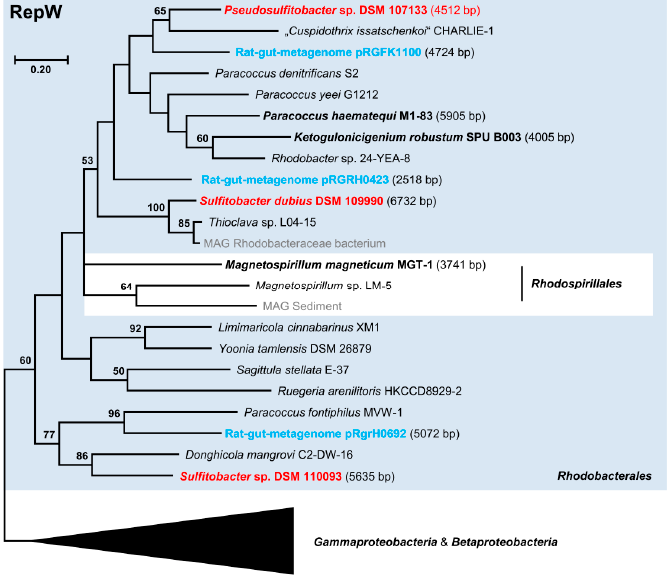
Figure 5. Phylogenetic Maximum Likelihood tree of 61 RepW type plasmid replication proteins based on 123aminoacidpositions. Bootstrapsupport>40%isindicated. Thereferencereplicasesof Pseudosulfitobacter sp. DSM 107133, Sulfitobacter dubius DSM 109990, and Sulfitobacter sp. DSM 110093 are shown in red. Circularplasmidsorcircularizedcontigsarehighlightedinbold. Rat-gutmetamobilome-derivedsequences are shown in blue, and sequences from MAGs are shown in gray. Sequences from Rhodobacterales are highlighted by a blue box. The complete tree is shown in Figure S7. Accession numbers, localization, and further characteristics of RepW type replicases are presented in Table